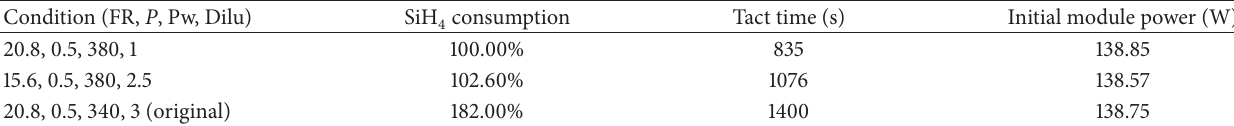
Table 2: The results of modulates fabricated with these three kinds of amorphous silicon intrinsic layer.